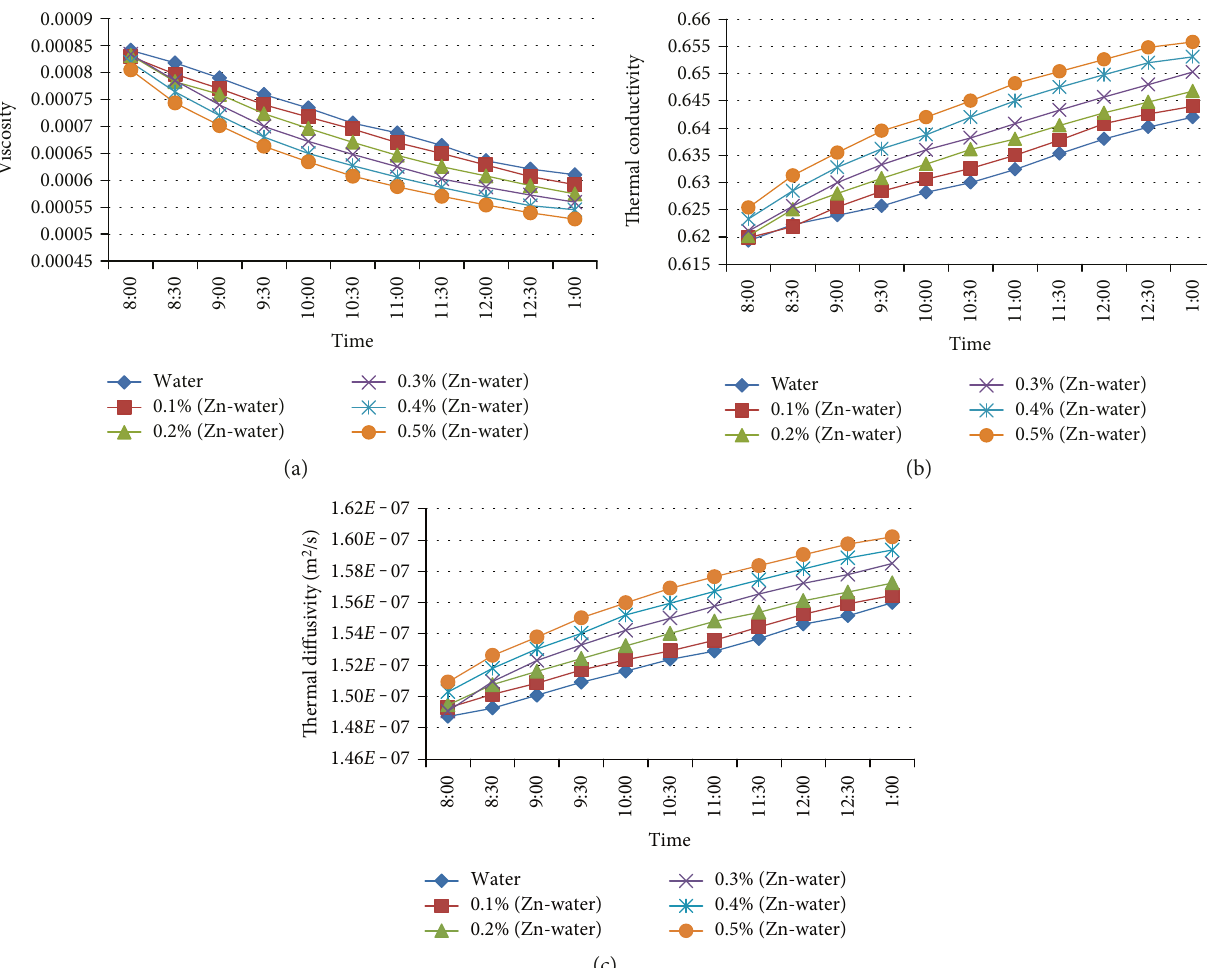
Figure 11: E ff ect of Zn-H O nano fl uid at 2L/min on (a) viscosity, (b) thermal conductivity, and (c) thermal di ff 2